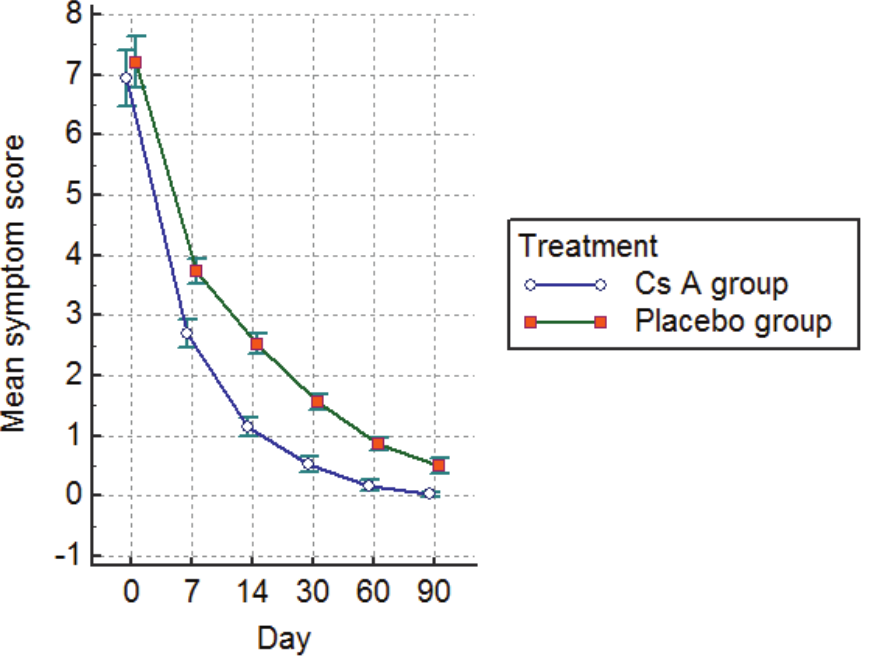
Figure 1. Mean symptom scores at baseline and during follow-up visits.